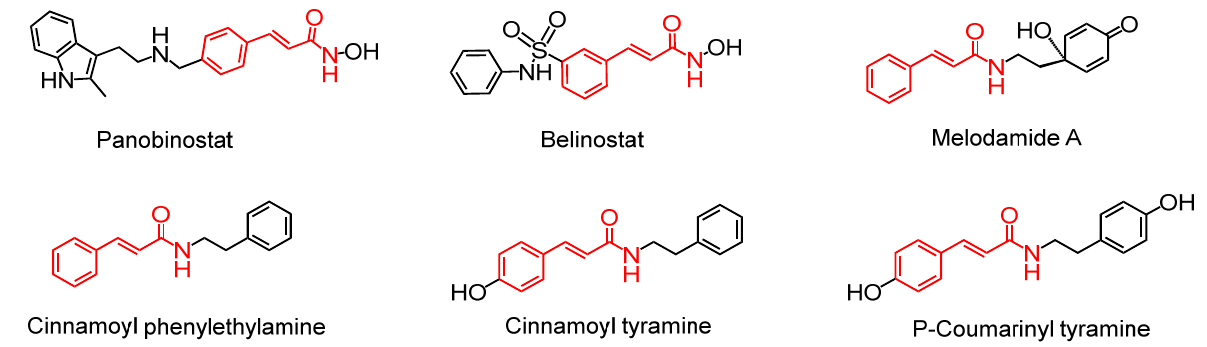
Figure 1. Structures of cinnamamide compounds with potential drug activities.